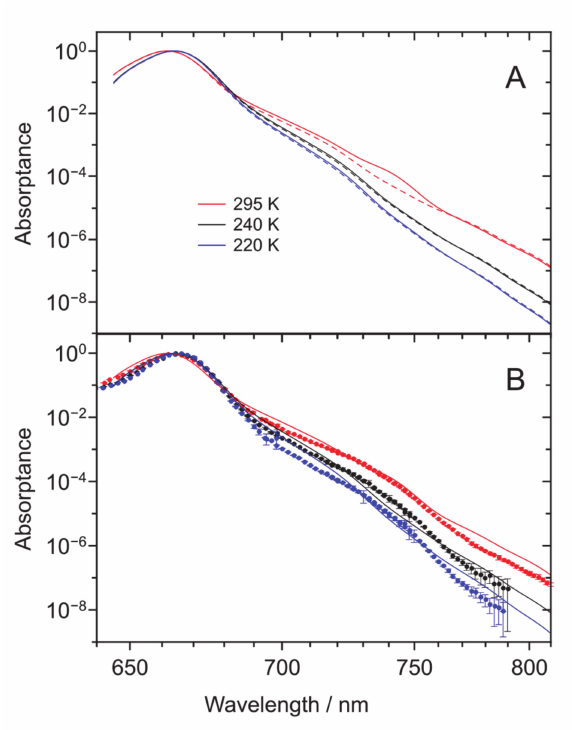
Figure 3. ( A ) Absorptance spectra of model Chl a : TEA calculated at di ff erent temperatures indicated. The calculated spectra involving either all fundamental modes and up to 20 overtones of each vibrational mode or the same together with υ i + υ j -type combinations of the modes, are presented by dashed or solid lines, respectively. ( B ) Comparison of the measured fluorescence excitation (discrete data) and calculated absorptance (solid lines) spectra. The spectra, normalized by the Q y absorption maximum, are color-coded as in Figure